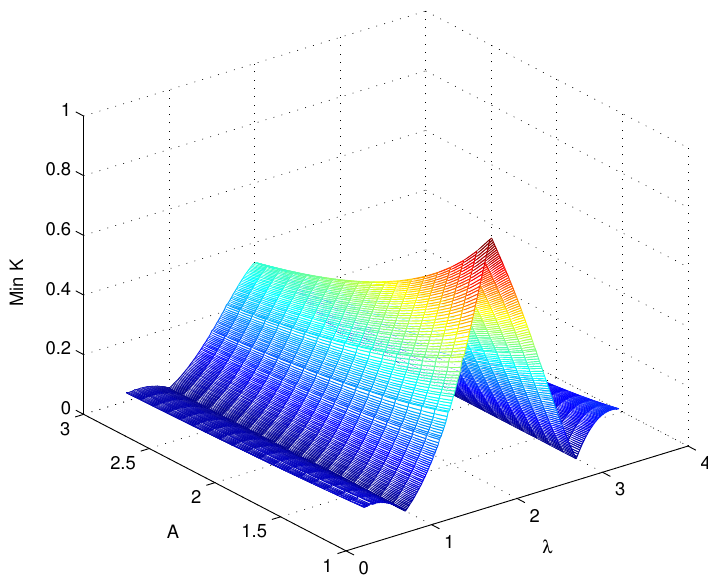
Figure 10. Minimal value of K